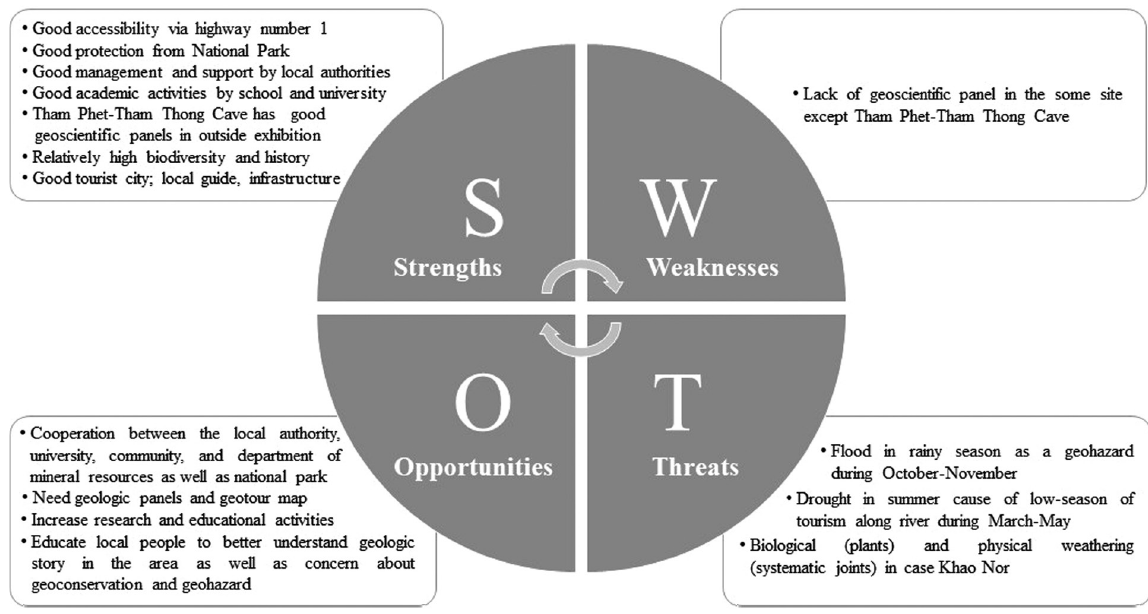
Fig. 6. The strategic planning technique used to identify strengths, weaknesses, opportunities, and threats related to the geoheritage and geotourism development in Nakhon Sawan Province.